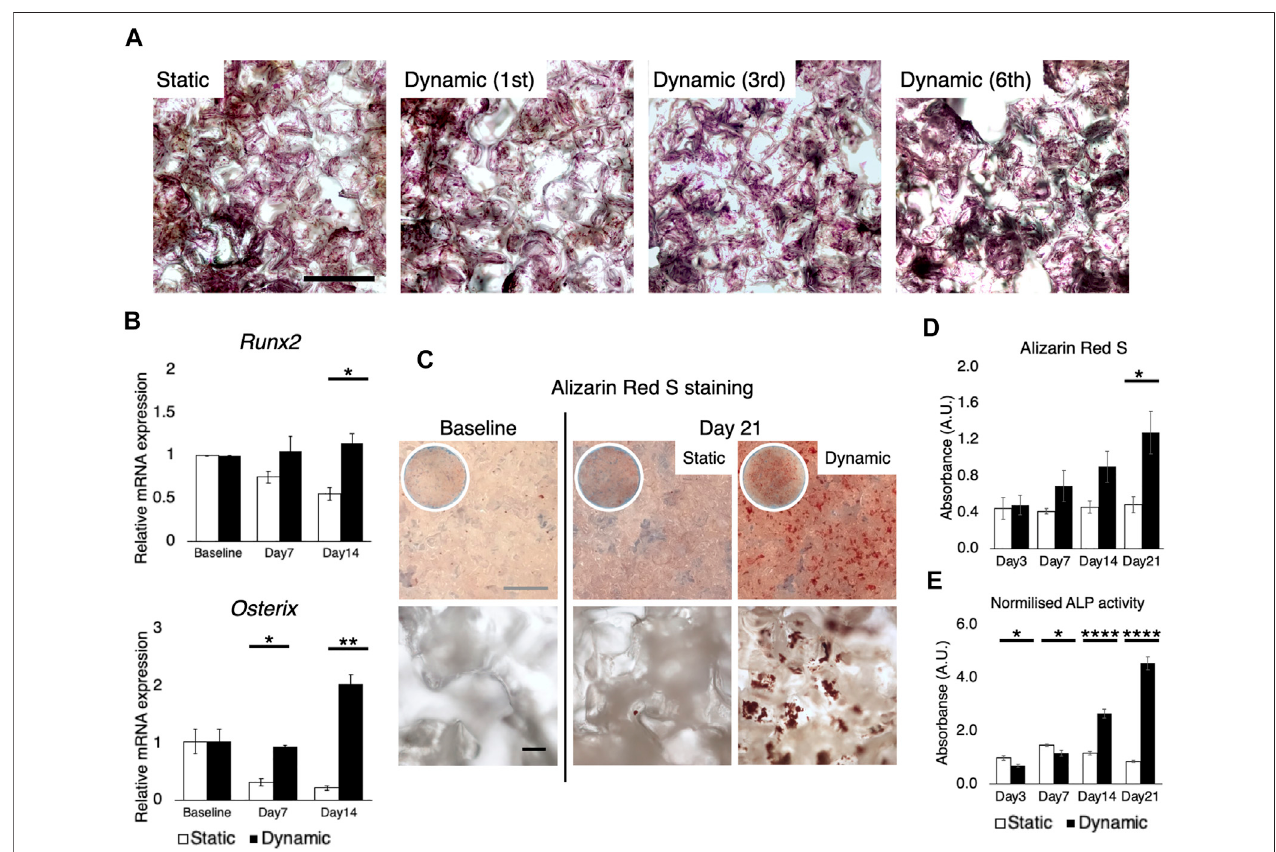
FIGURE 7 | Osteogenic differentiation induced solely by fl uid stimuli at 0.8 ml/min. (A) Crystal violet staining showed, as expected from the computational simulation, that the cells were uniformly distributed throughout the stack of scaffolds, regardless of the distance from the inlet. Scale bar: 500 µm (B) RT-qPCR showed theupregulationofkeytranscriptionfactorsforosteogenesis,RUNX2andosterix,ondays7and14underperfusionwhilethecellsgraduallylosttheosteogenicproperty in the static environment. Baseline stands for 24 h after cell seeding on the scaffold (C,D) Alizarin red S staining con fi rmed the formation of mineralized deposit on thescaffoldssubjectedtoperfusionfor21 days.Scalebar:(grey)1 mm,(black)100 µm (E) Perfusioncultureledtotheactivationofalkalinephosphataseactivityondays 14 and 21. * p < 0.05, ** p < 0.01, *** p < 0.001, **** p <